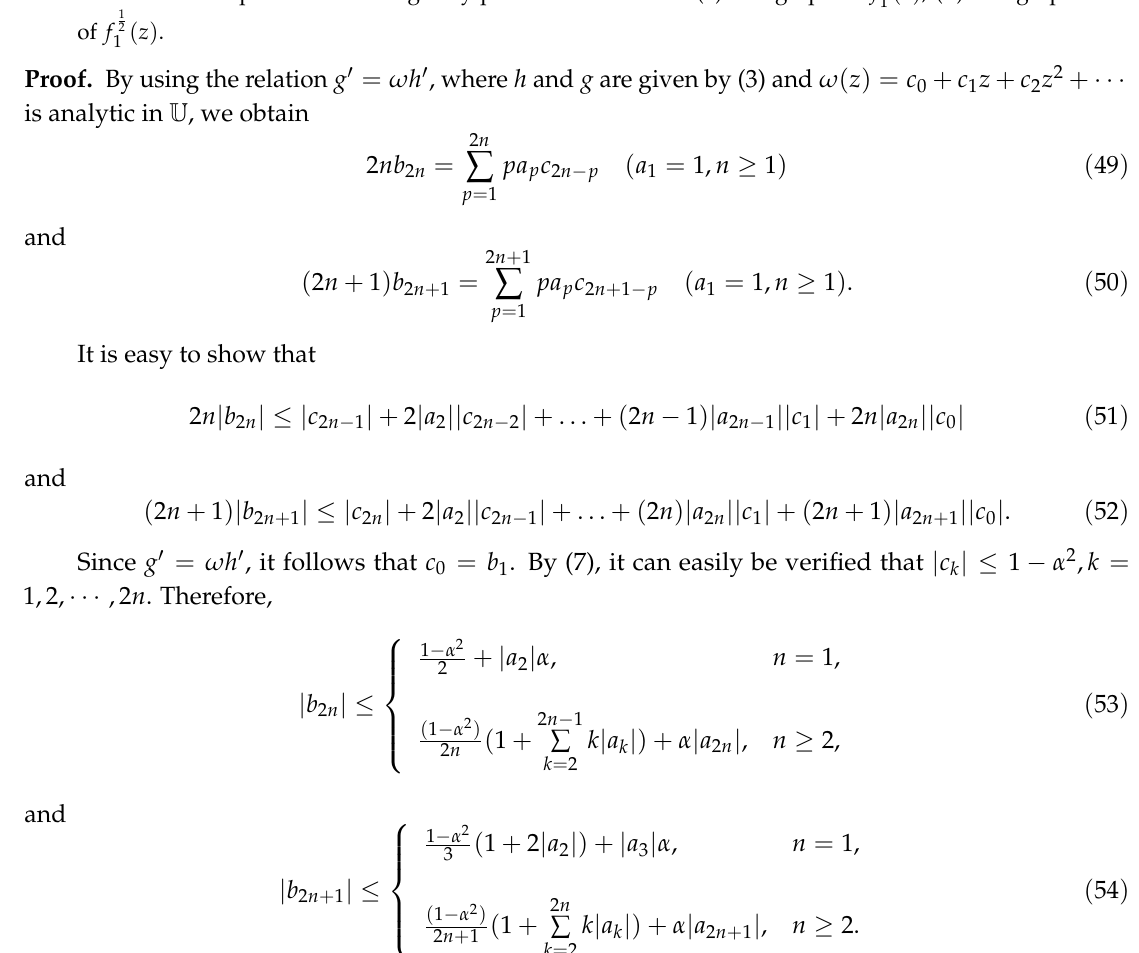
( z ) ; ( b ) The graph 1